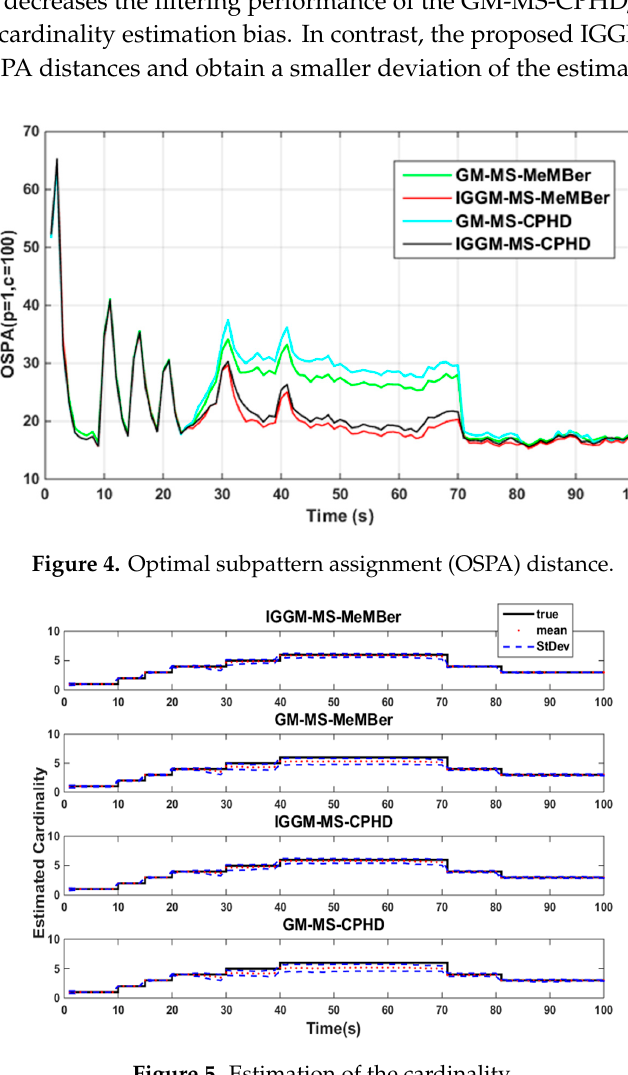
Table 3. Average single-step running time. IGGM-MS-CPHD